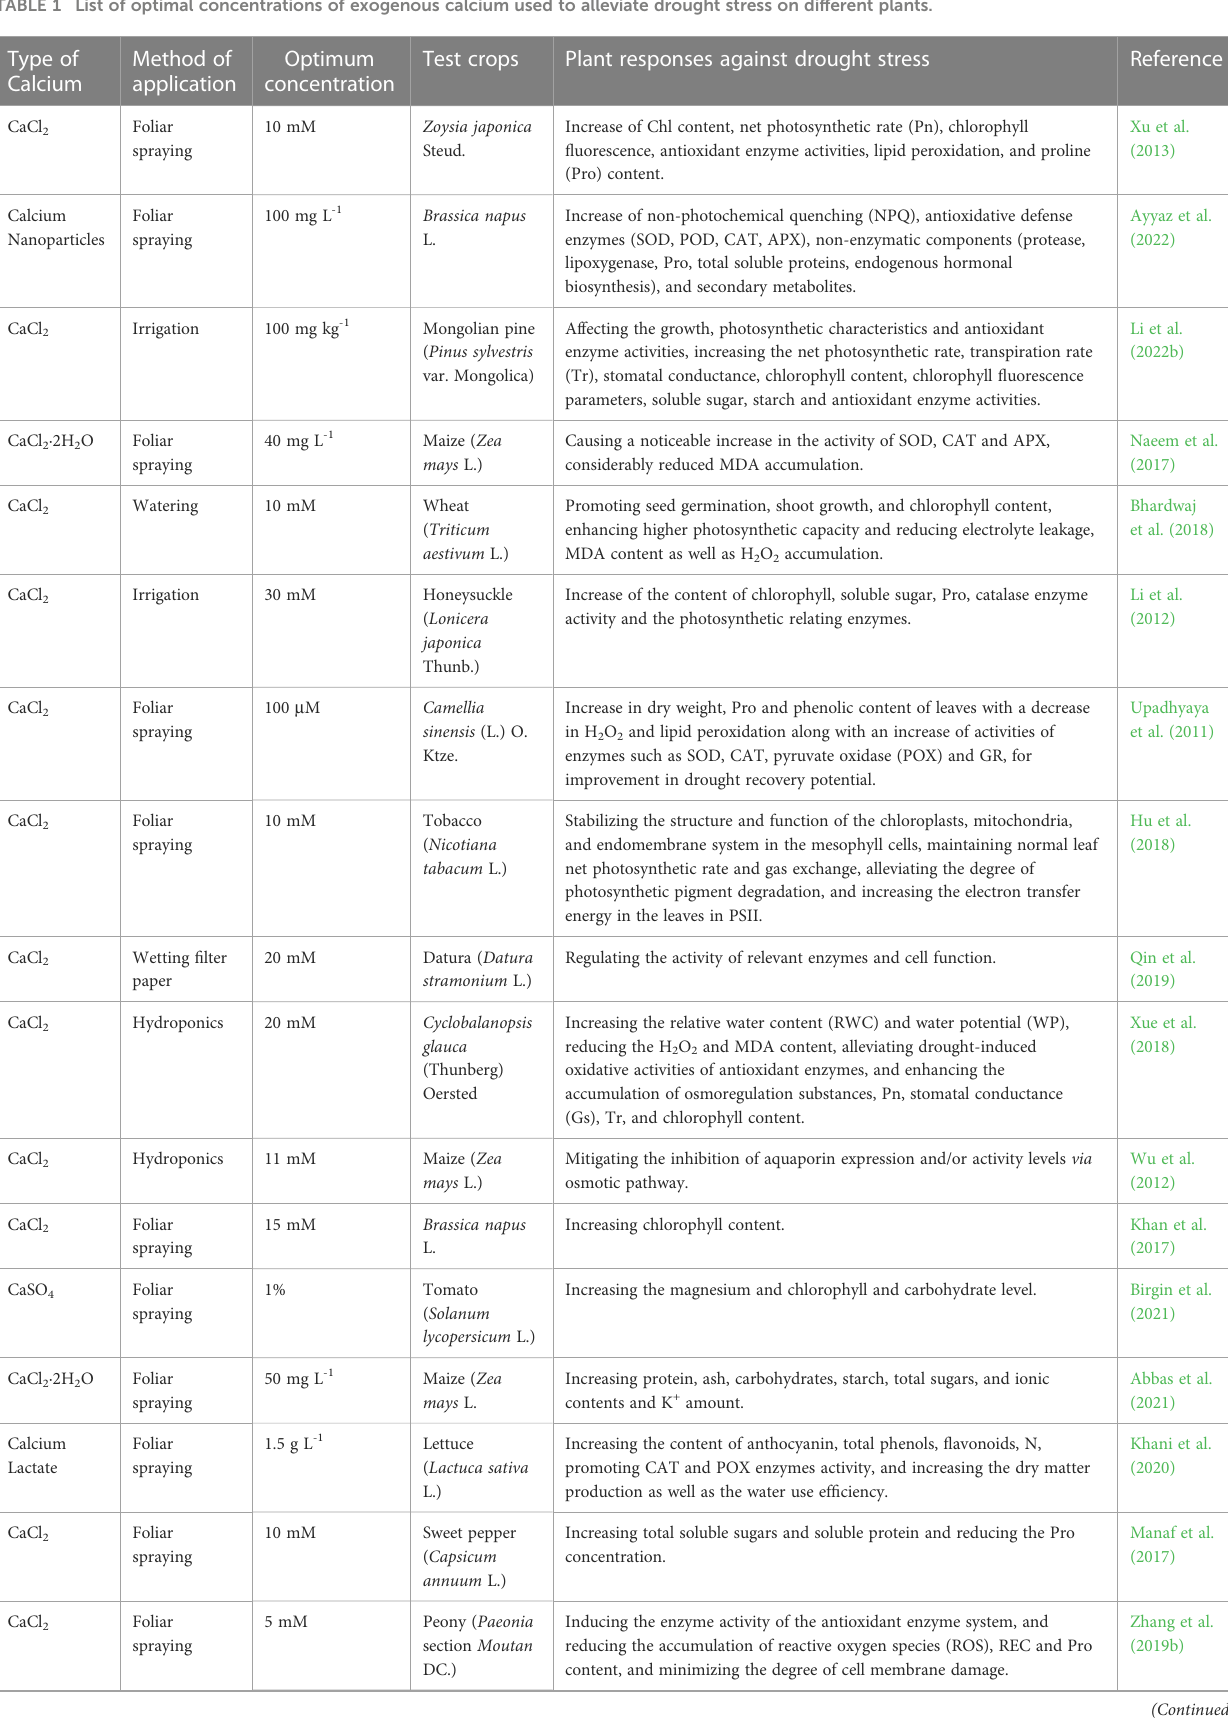
TABLE 1 List of optimal concentrations of exogenous calcium used to alleviate drought stress on different